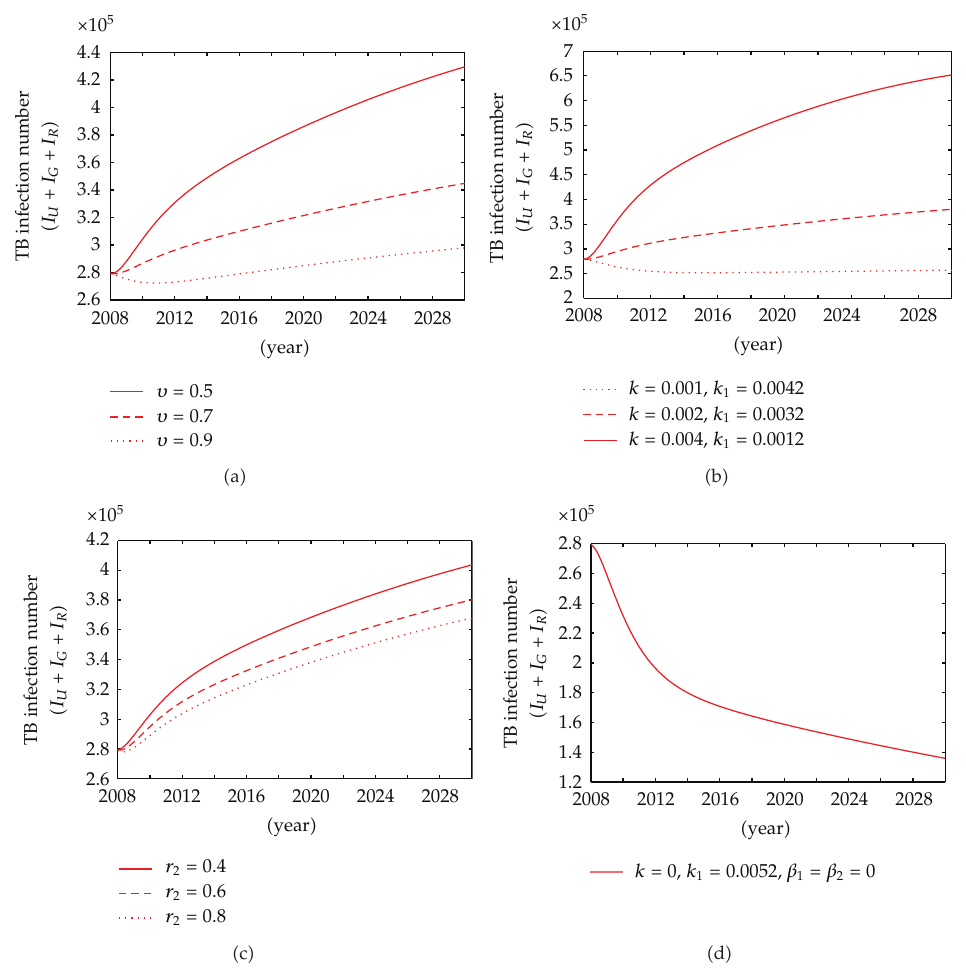
Figure 4: Simulations with di ff erent parameters. (cid:2) a (cid:3) Di ff erent discovery rates. (cid:2) b (cid:3) Di ff erent detected rates in time. (cid:2) c (cid:3) Di ff erent treatment rates of the MDR-TB patients. (cid:2) d (cid:3) All TB infection cases are detected in